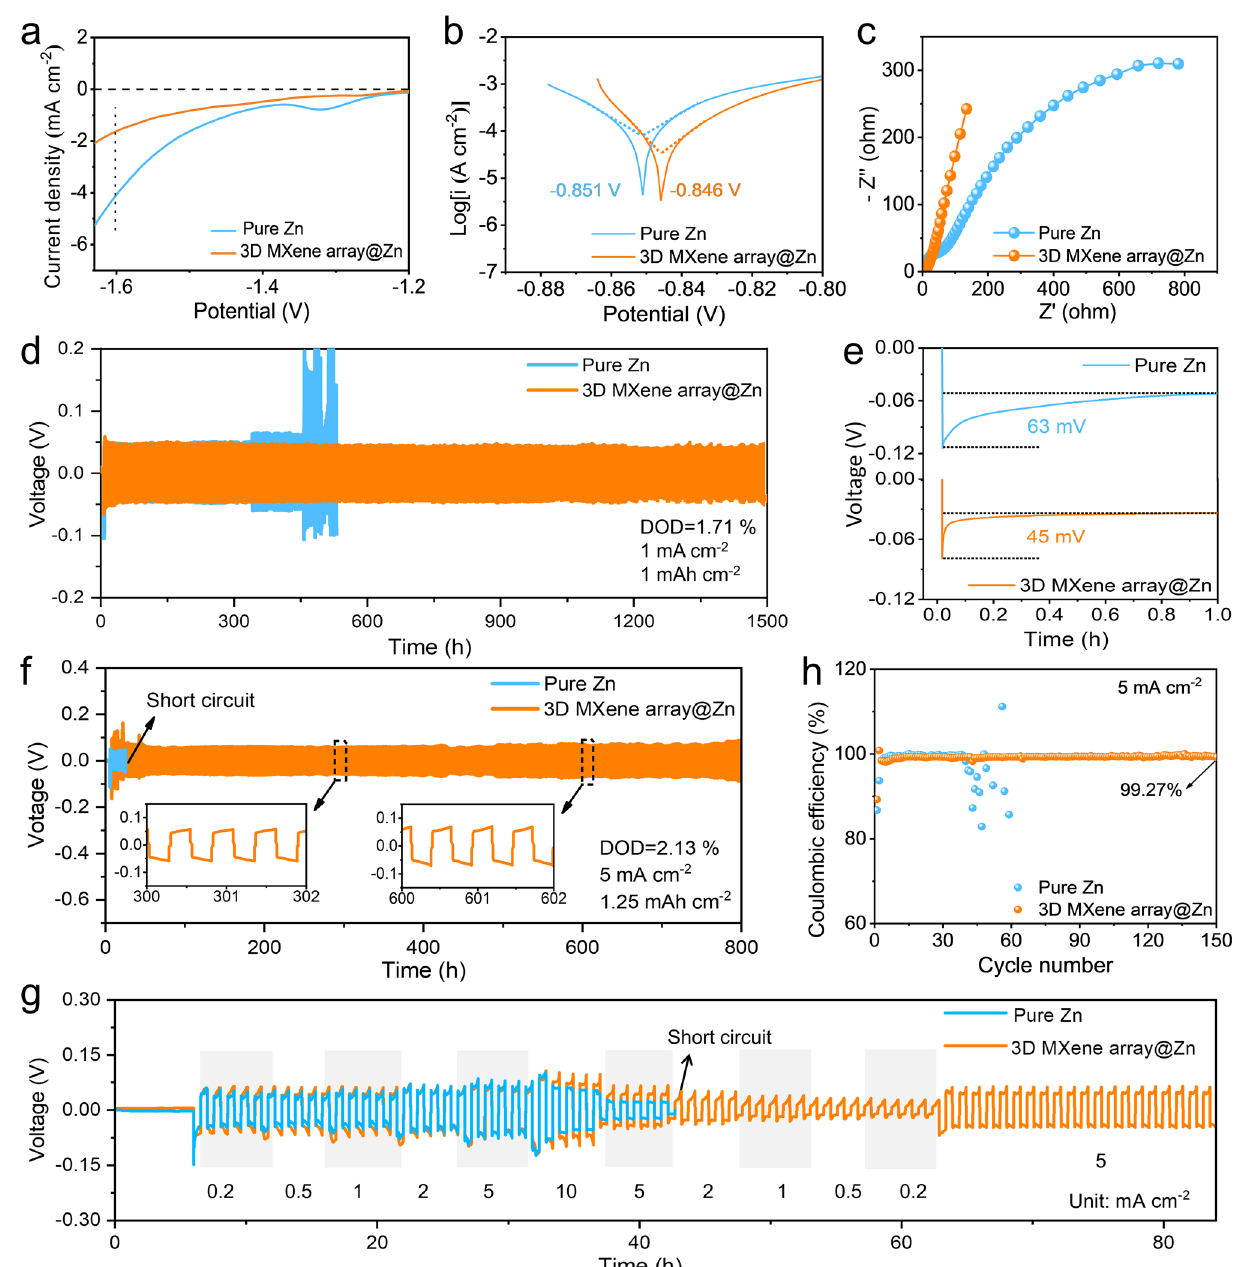
Fig. 2 a LSV curves of pure Zn and 3D MXene array@Zn in 1 M aqueous Na 2 SO 4 electrolyte at a scan rate of 1 mV s −1 . b Tafel curves of pure Zn and 3D MXene array@Zn in 3 M Zn(CF 3 SO 3 ) 2 electrolyte at a scan rate of 1 mV s −1 . c EIS spectroscopy of 3D MXene array@Zn (Zn) symmetric cell. d Long-term cycling performance of Zn symmetric cell at the condition of 1 mA cm −2 and 1 mAh cm −2 , and e corresponding nucleation overpotential. f Long-term cycling performance of Zn symmetric cell at the condition of 5 mA cm −2 and 1.25 mAh cm −2 . g Rate per- formance test. h Coulombic efficiency of Zn/Cu asymmetric cells with 3D MXene array@Zn anode and pure Zn anode under the current density of 5 mA cm